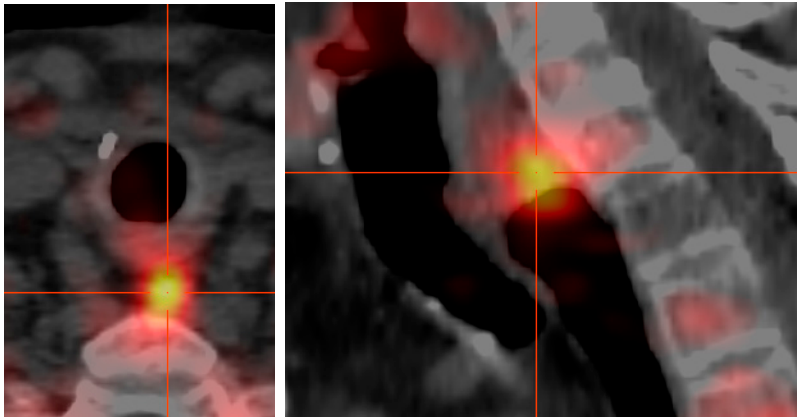
Figure 2. a+b Parathyroid adenoma (PA) of the descended upper left gland in a patient who had total thyroidectomy and central lymph node dissection because of thyroid cancer 10 years earlier. Table 2. Absolute numbers and percentage of patients with positive and negative localization of a parathyroid adenoma in the preoperative work-up for all patients and subgroups with either previous thyroid or parathyroid surgery and the respective number of positive findings in FEC- PET-CT&4D-CT.